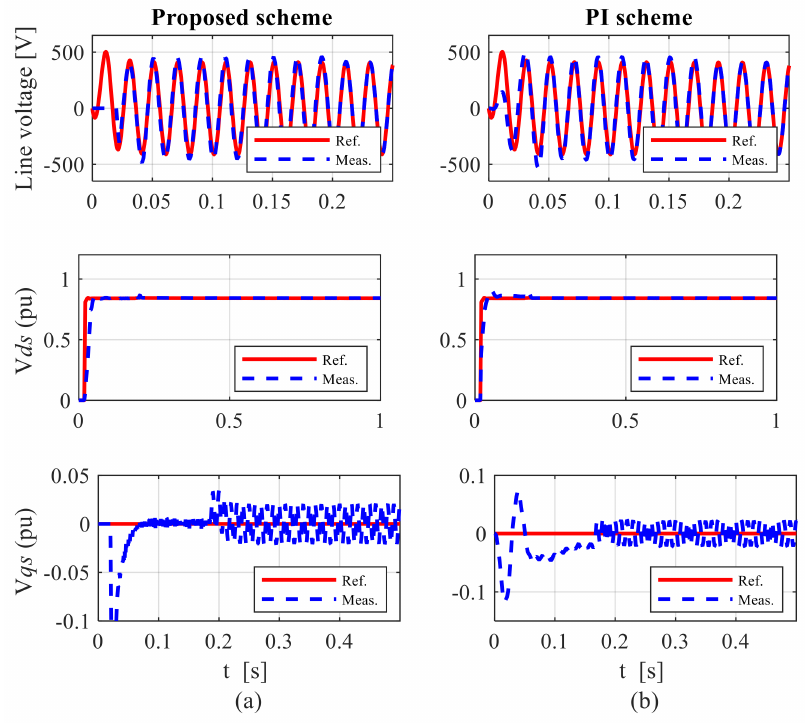
Figure 9. Control performances during sub-synchronous speed operation under unbalanced grid conditions: ( a ) proposed scheme and ( b ) PI scheme.